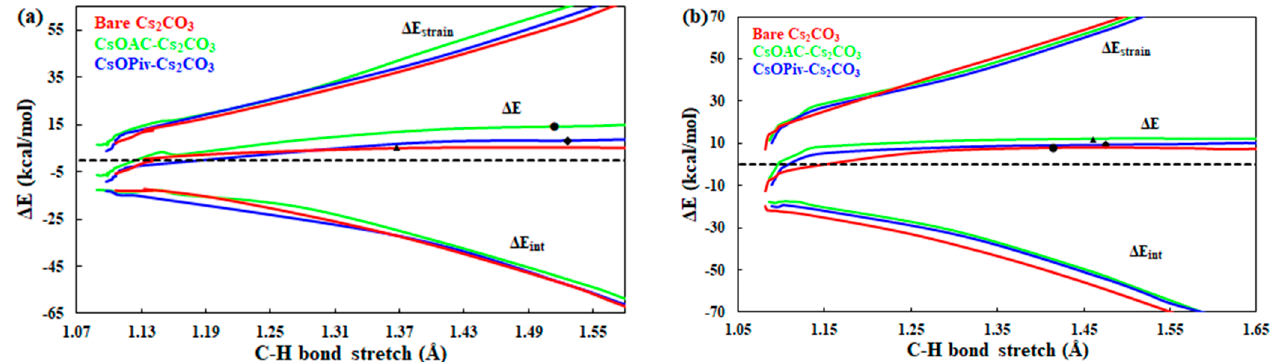
Figure 3. The transition structure for CsOPiv–Cs 2 CO 3 system: ( a )TS_1 and ( b ) TS_3.